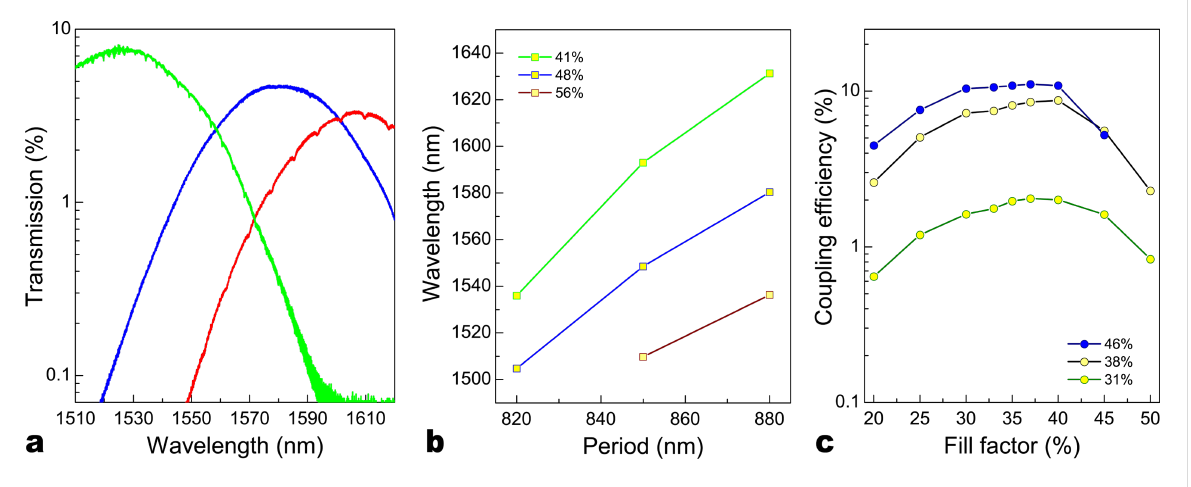
Figure 3: (a) Measured transmission spectrum of typical grating coupler devices. Best coupling loss at the central coupling wavelength of − 5.0 dB is obtained. (b) The measured dependence of the central coupling wavelength on the grating period, which allows us to target specific wavelength windows over the coupler bandwidth of 50 nm. (c) The measured coupling efficiency for a pair of grating couplers in dependence of fill factor and etch depth. Optimal performance is obtained for gratings etched half way through the diamond layer.